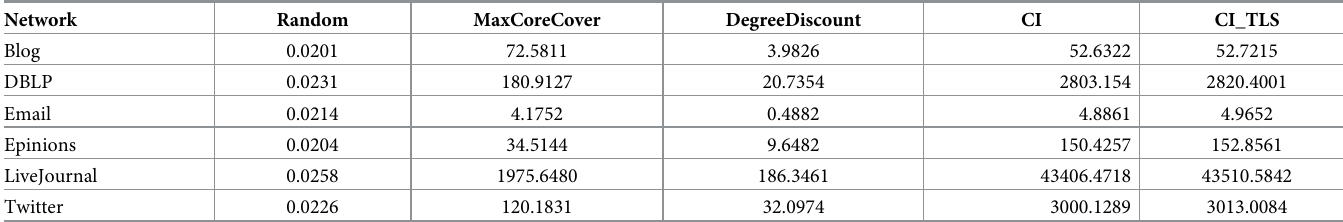
Table 2. The CPU times (in seconds) of five measures for six